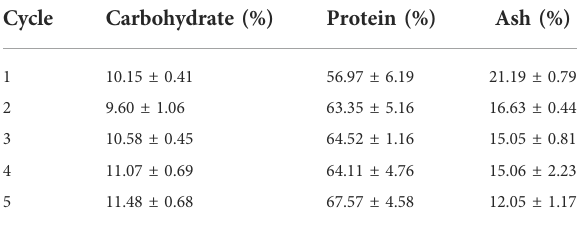
TABLE 3 Biochemical composition (carbohydrates, protein, and ash) ofthe cyanobacterial consortium over fi vecycles of reusing spent